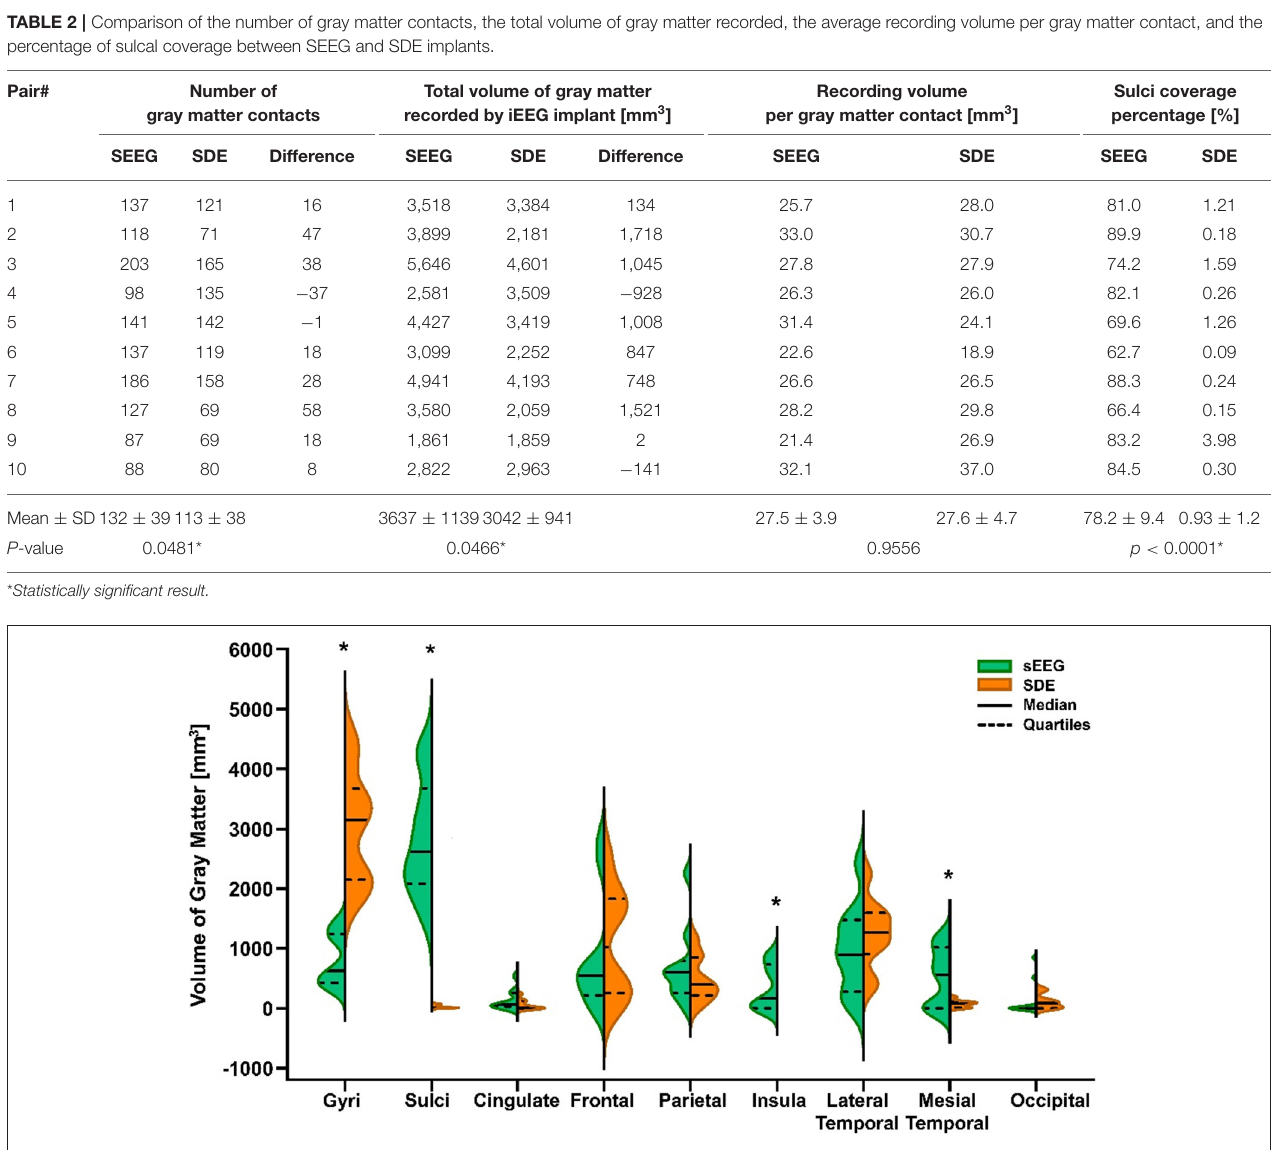
FIGURE 2 | Violin plot of volume of gray matter recorded by SEEG and SDE implants in gyri, sulci, and 7 cortical regions of interest (ROIs) for the entire cohort. Statistically significant differences (*) between pair-matched SEEG and SDE cases were found in gyri (paired t -test, p < 0.0001), sulci (paired t -test, p < 0.0001), insula cortex (Wilcoxon test, p = 0.0156), and mesial temporal cortex (Wilcoxon test, p = 0.0273). Increased sampling over the lateral temporal lobe with SDE was not statistically significant.